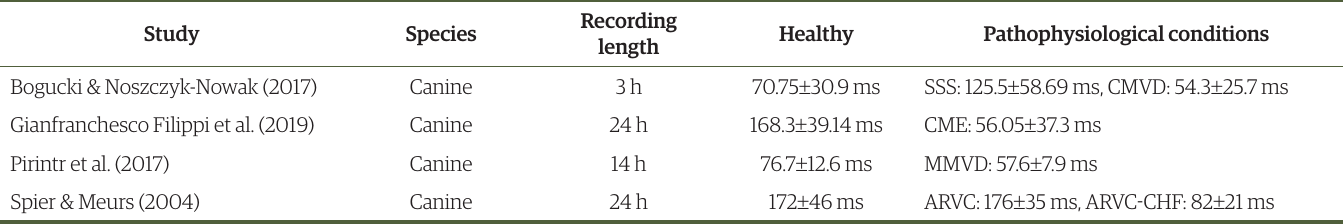
Table 2. Summary results of selected studies from the literature, depicting the recording length for data acquisition and the SDANN values for healthy animals or those presenting pathophysiological